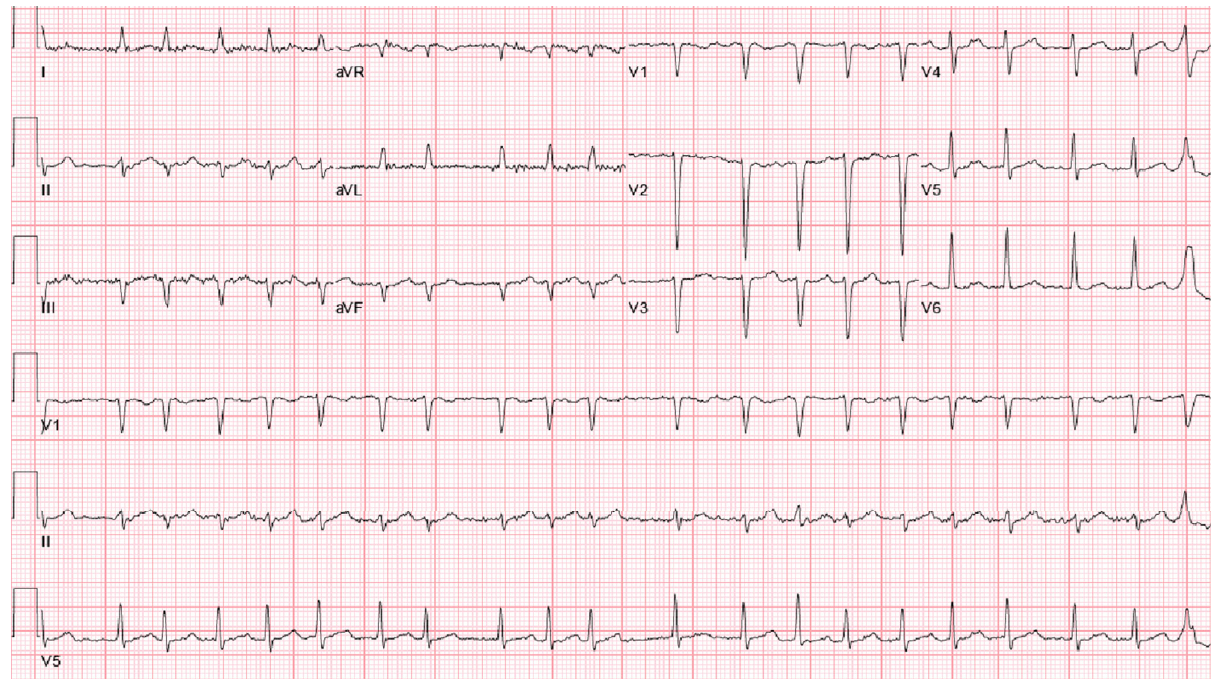
Figure 2: Electrocardiogram. Initial electrocardiogram revealing atrial fi brillation with fast ventricular response (126bpm). There were no new ST-segment changes suggestive of acute ischemia.